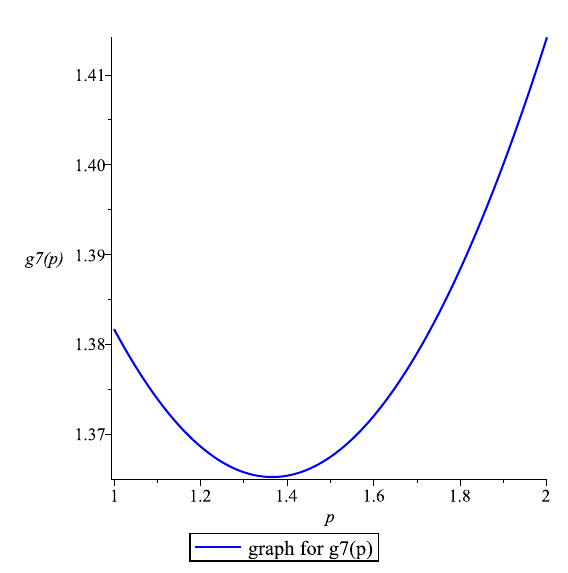
Figure 3. Graph for g 7 ( p )